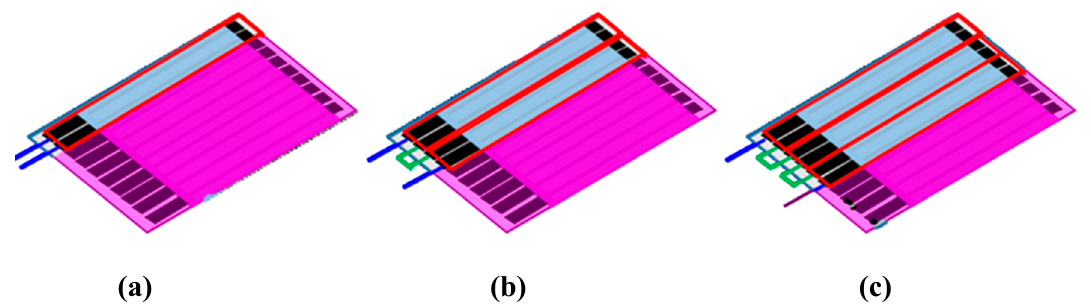
Figure 3. ULBP2-SPCEs in array configuration: Each red rectangle represents each of the identical ULBP2-SPCEs. The blue lines are connected to an impedance analyzer, and the green lines connect identical ULBP2-SPCEs in series: ( a ) 1 × 1 array configuration (i.e., ULBP2-SPCE), ( b ) 1 × 2 array configuration (i.e., ULBP2-SPCE-1 × 2), and ( c ) 1 × 3 array configuration (ULBP2-SPCE-1 × 3).